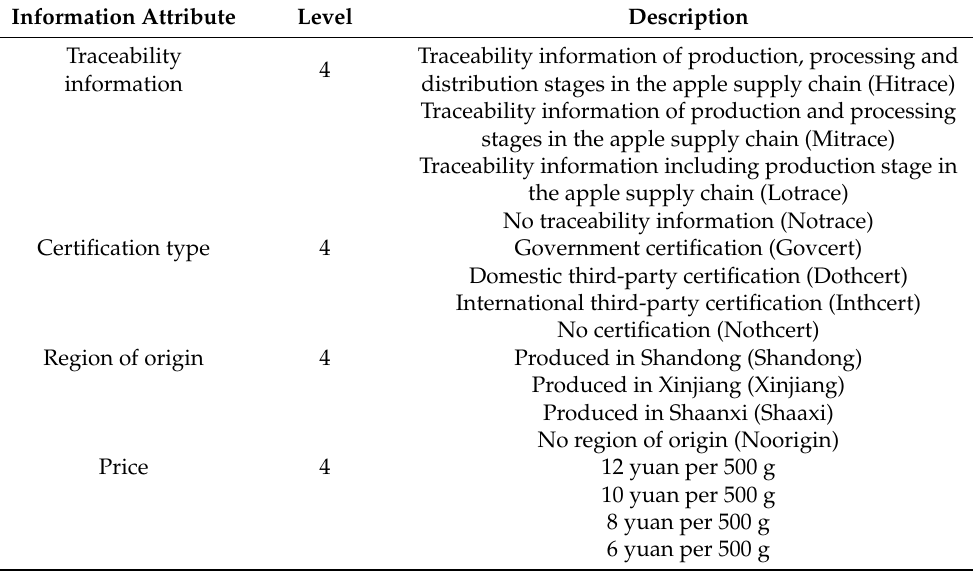
Table 1. Fuji apple information attributes in the choice